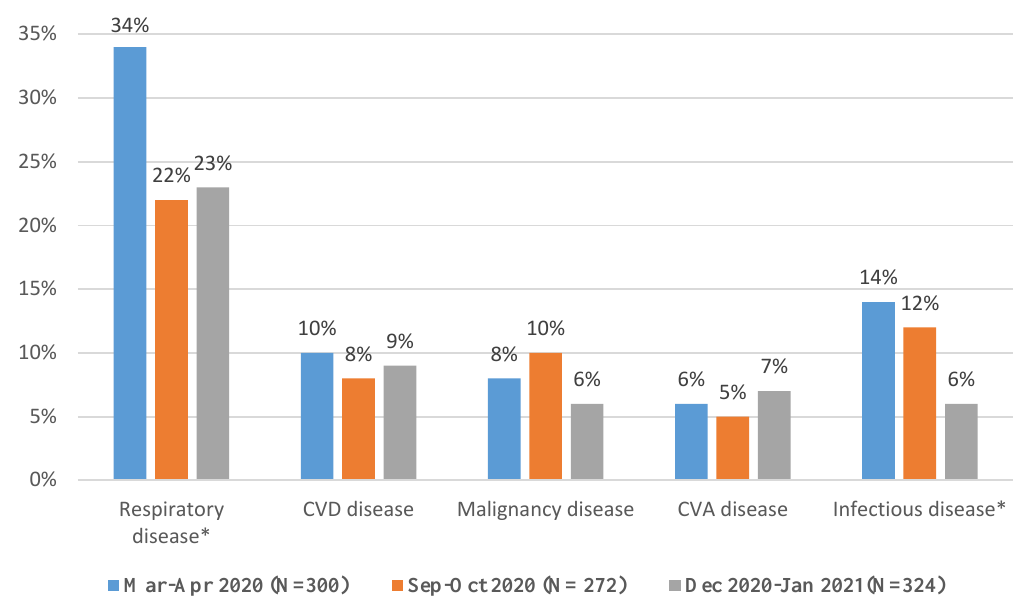
Figure 1. The prevalence (percent) of main five causes of death among non-COVID-19 patients during the first, second, and third lockdowns. * Indicates statistically significant difference among the three periods; n = the total number of non-COVID-19 deaths.